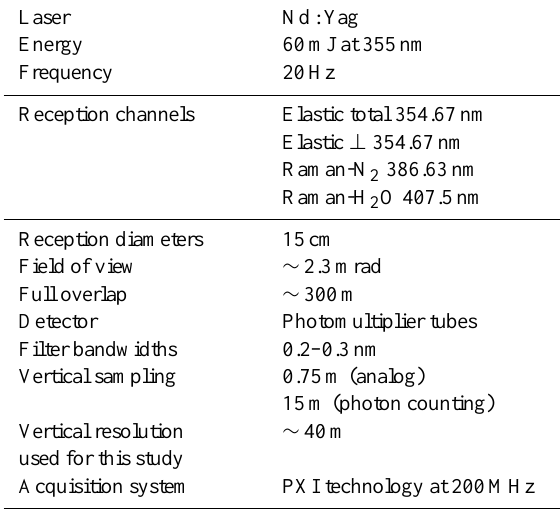
Table 1. Main technical characteristics of the WALI